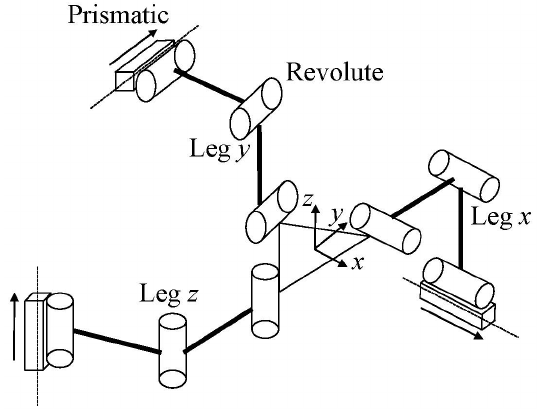
Figure 1. The kinematic diagram of Tripteron .